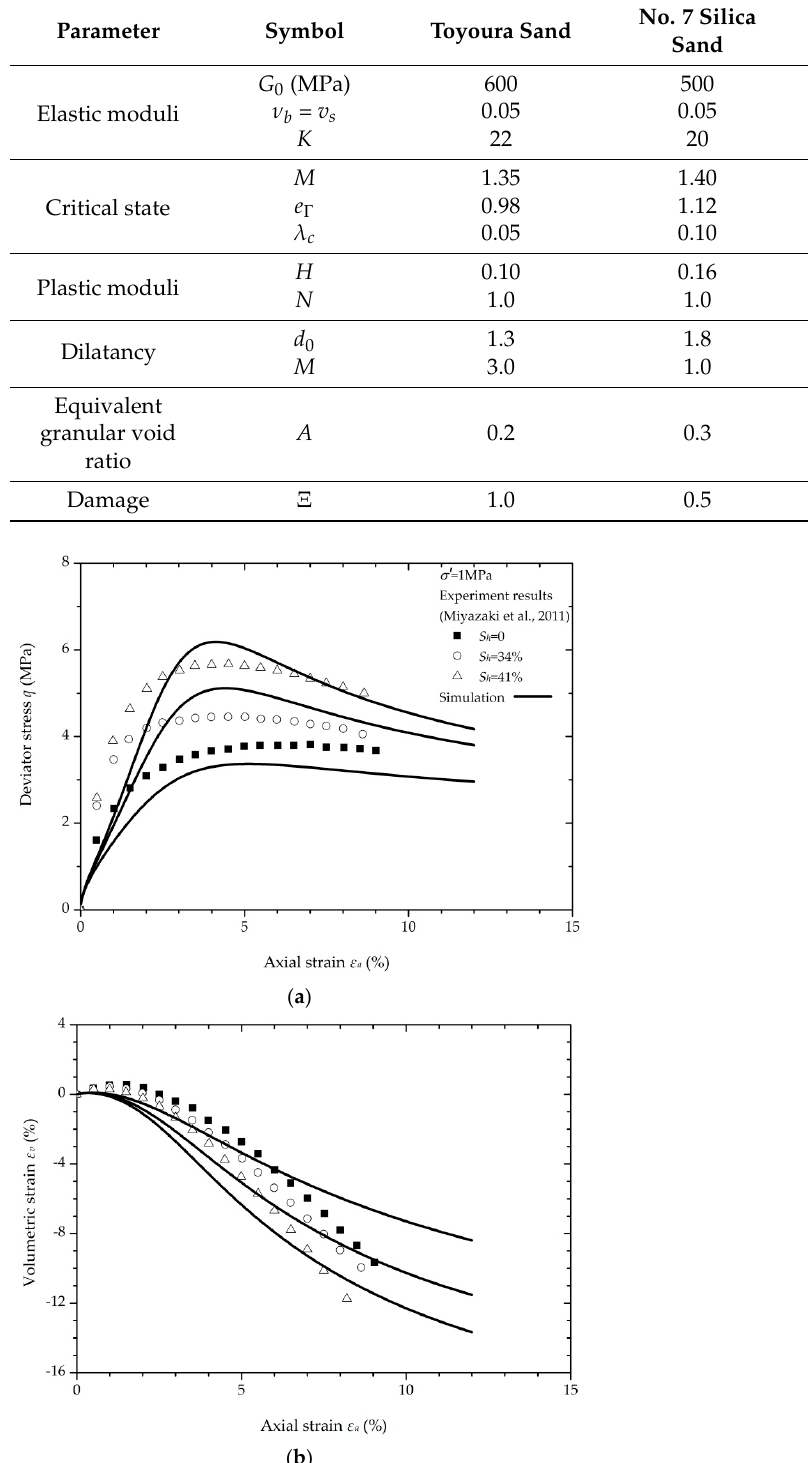
Figure 7. Comparison between drained triaxial test results and model predictions for MHBS synthesized from Toyoura sand: ( a ) relationship between deviator stress q and axial strain ε a ; ( b ) relationship between volumetric strain ε v and axial strain ε a . Table 2. Parameters for MHBS synthesized from different sands.